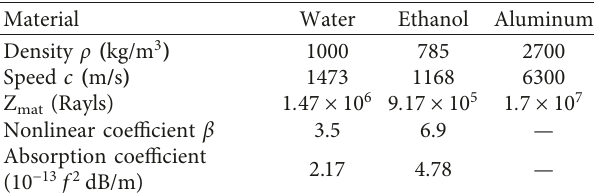
Table 1: Density and sound speed